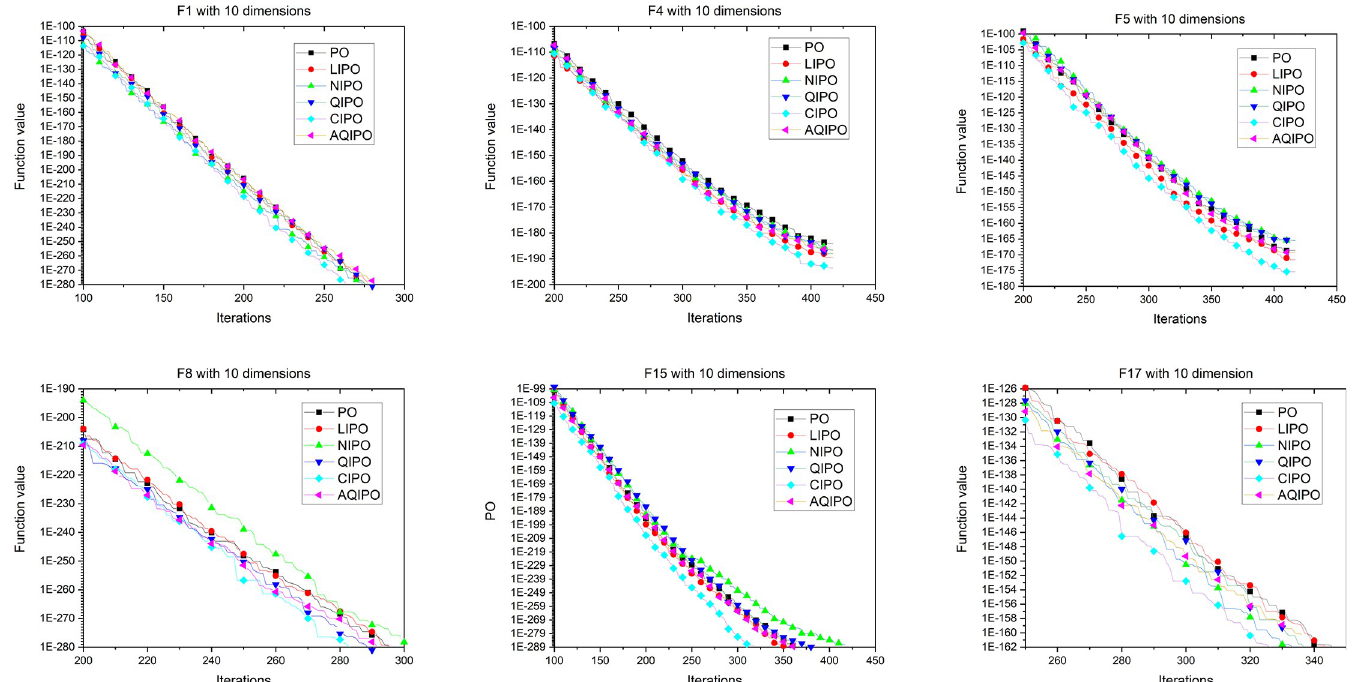
Fig 8. Convergence curve on 6 representative benchmark functions with 10 dimensions.